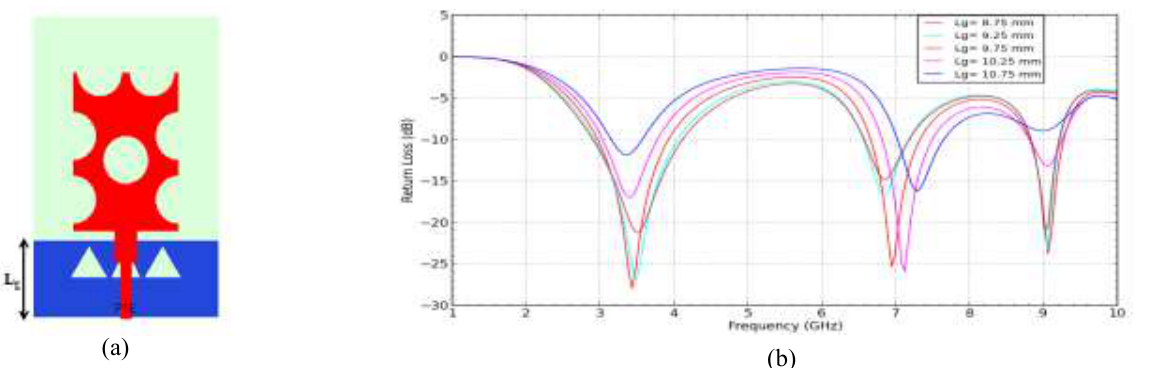
Figure 6: (a) Variation in ground length L g and (b) its corresponding optimization